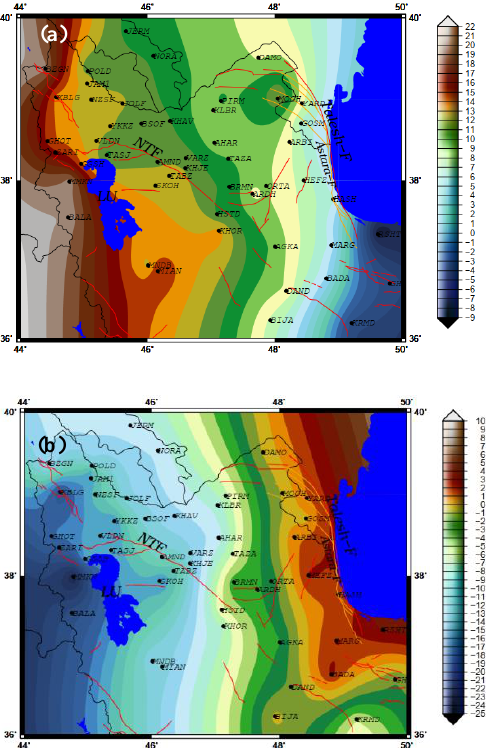
Figure 6. (a) Normal strain rate along the x-axis. (b) Normal strain rate along the y-axis. All values reported in part per billion per year